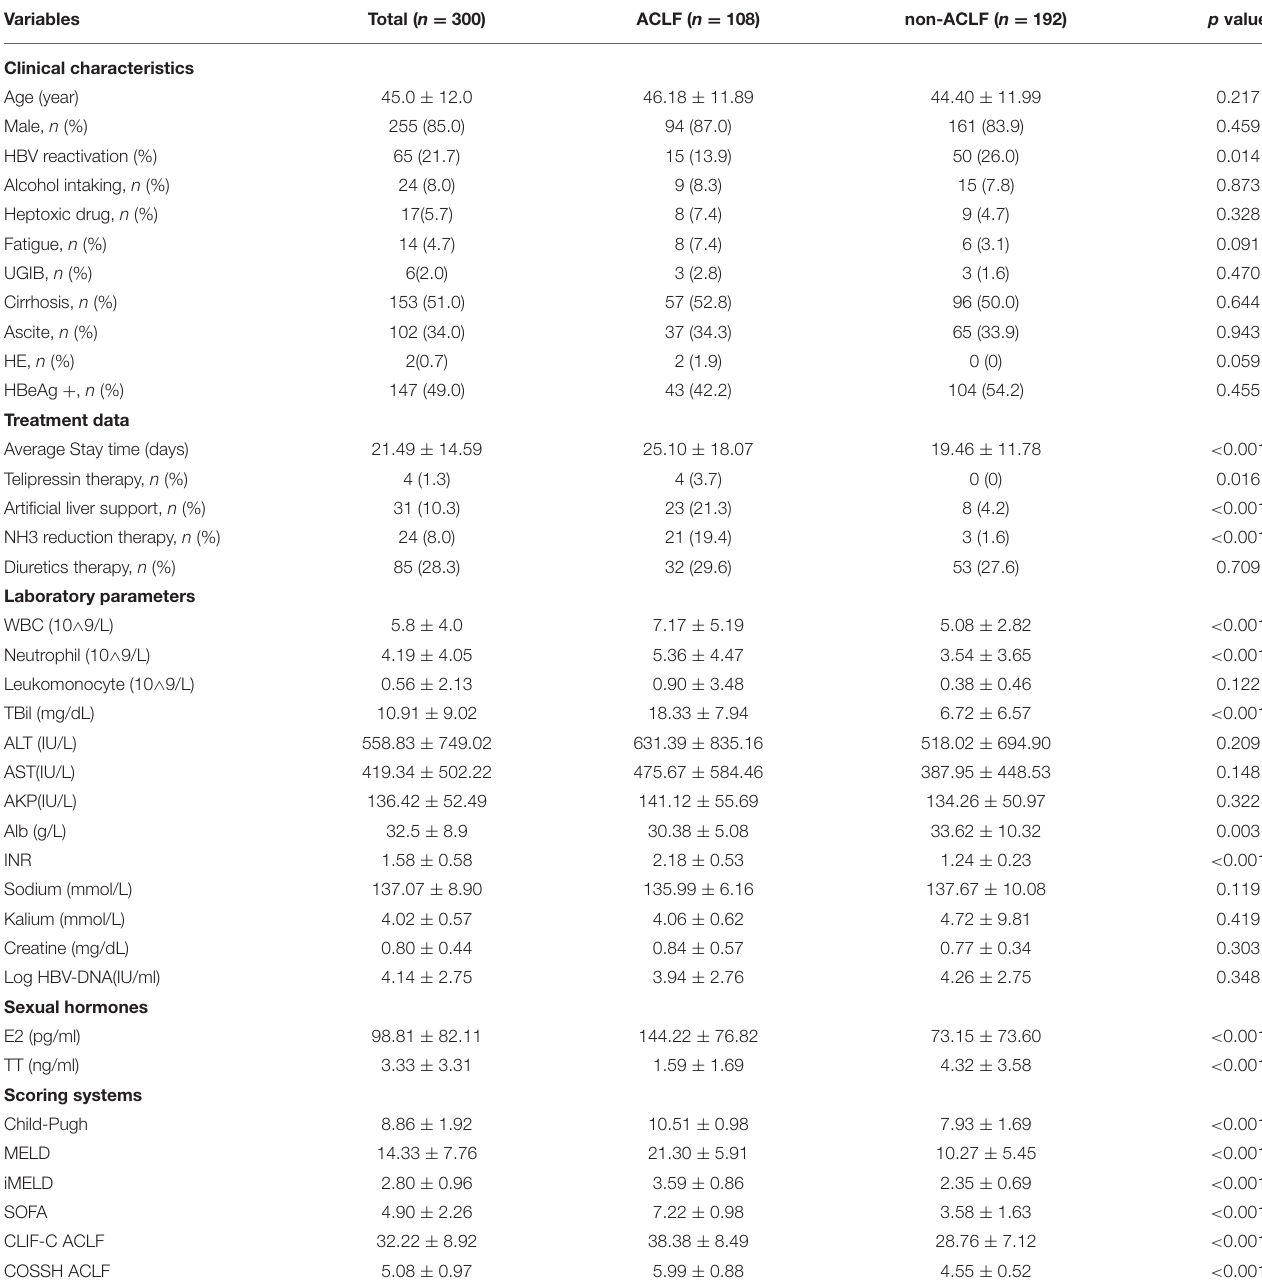
TABLE 1 | Baseline characteristics of CHB